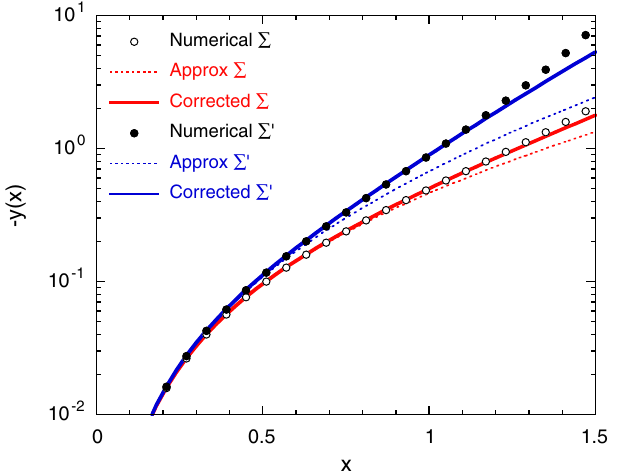
(cid:2) (cid:3) . F T